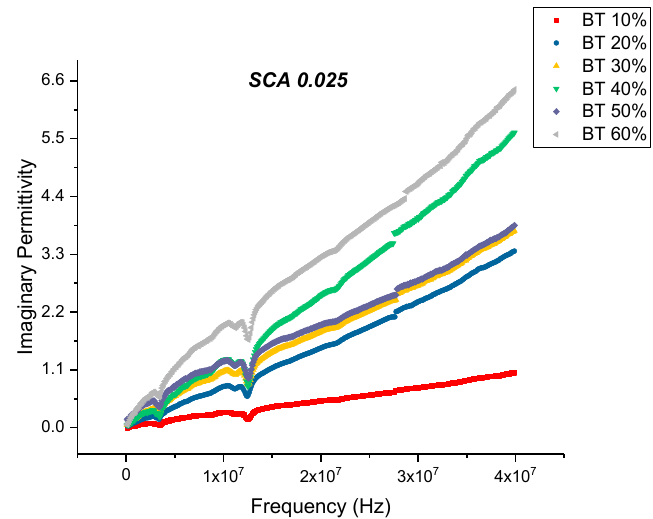
Figure 15. The dissipation factor of the BaTiO 3 -epoxy composite that were fabricated using BaTiO 3 nanoparticles which were surface modified using 0.025 SCA is plotted as a function of frequency where the volume fraction of BaTiO 3 is varied from 0.1 to 0.6. The maximum value is 3.26 for BaTiO 3 at 0.6 volume fraction.